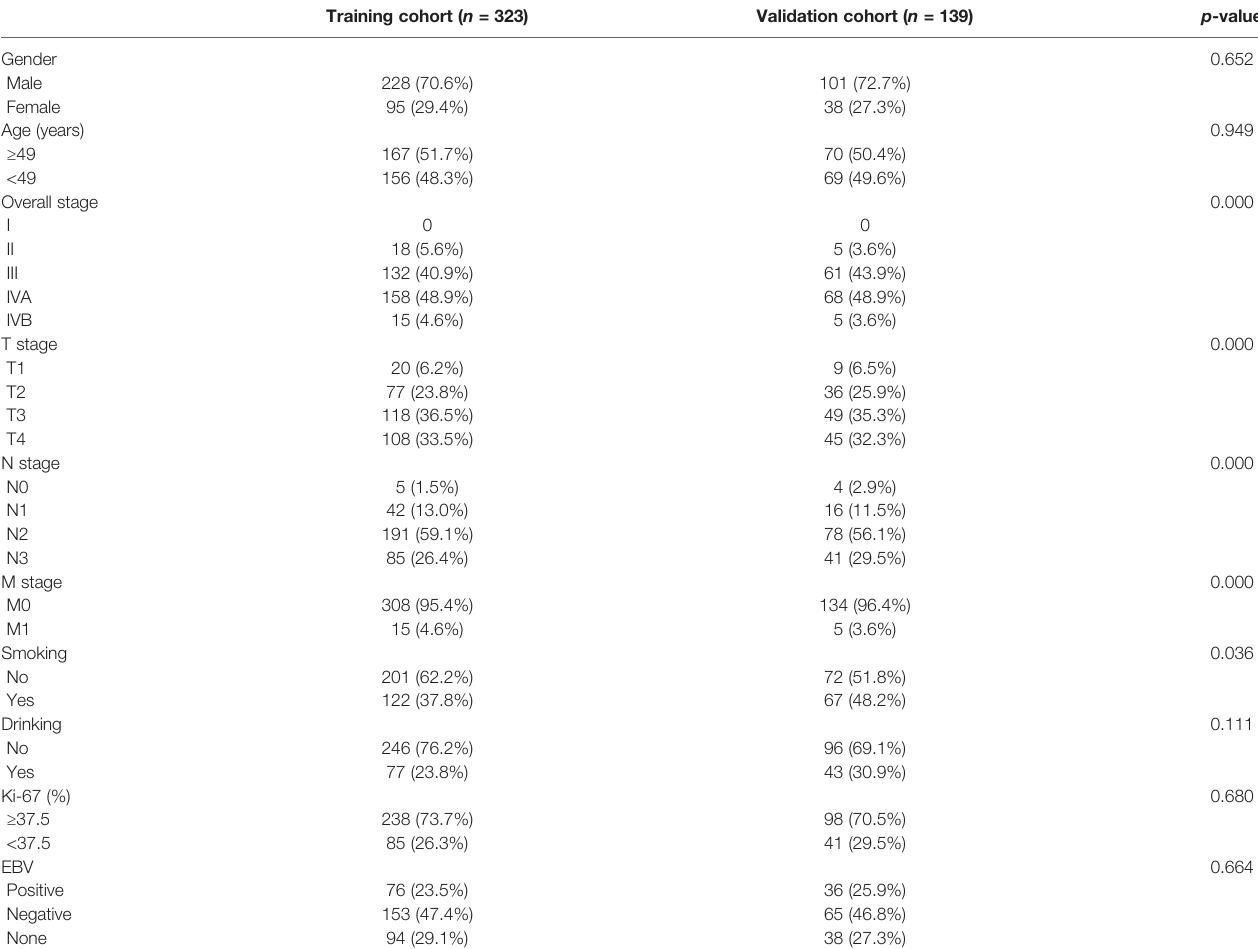
TABLE 1 | Clinical parameters of patients in the training and validation